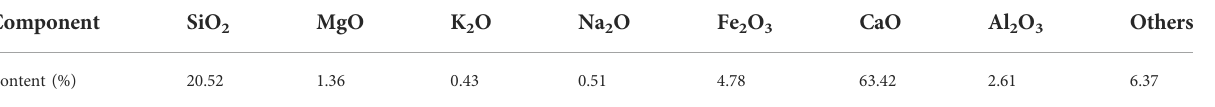
TABLE 1 Chemical composition of Jiahua grade G oil well cement.